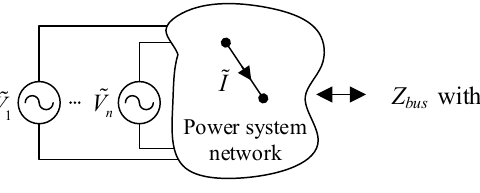
Figure 1. Power system network.